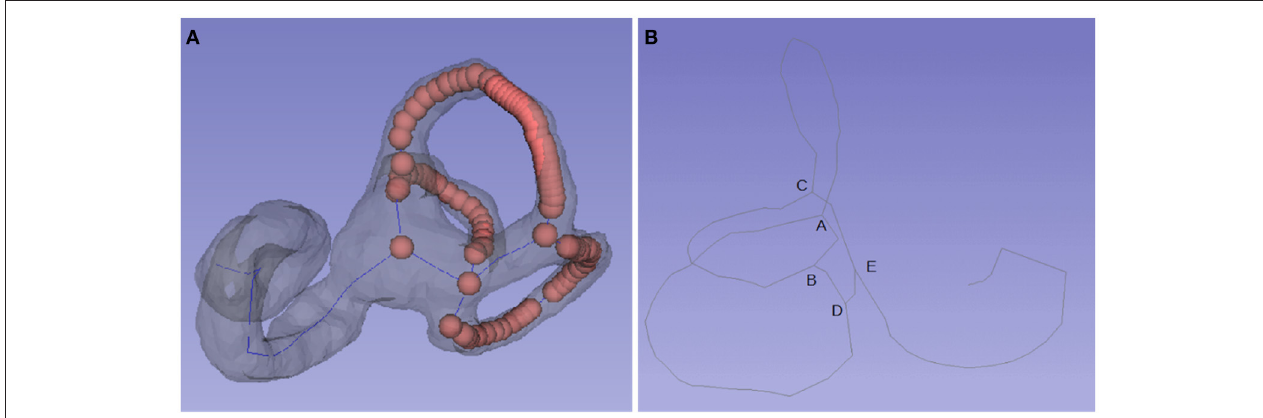
FIGURE 1 | Centerline and key points of the semicircular canal. (A) The centerline of the semicircular canal is comprised of a set of points. (B) Most centerlines include four key points: A, B, C, and D. A is the bifurcation of the common crus, AD is the posterior semicircular canal, AC is the anterior semicircular canal, BC is the lateral semicircular canal, and point E is located in the utricle.